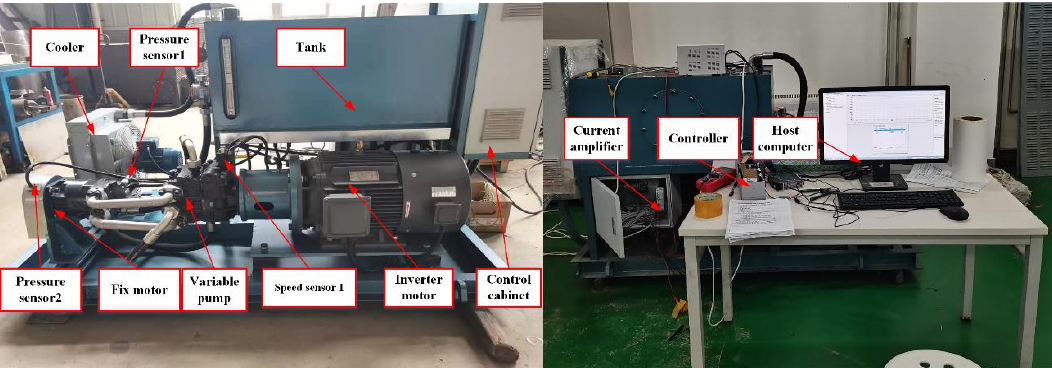
Figure 2. Pump-motor hydraulic system test bench.